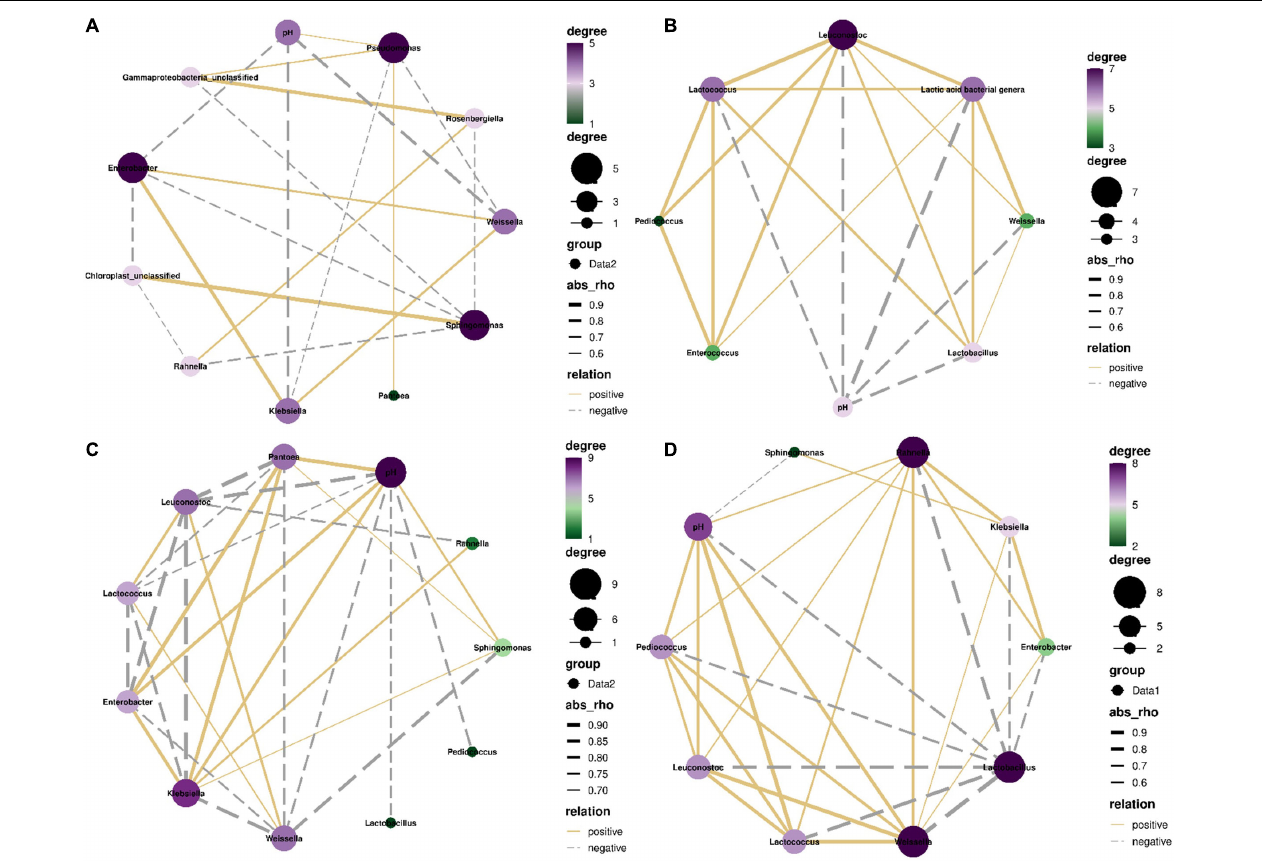
FIGURE 7 | Correlation networks among main bacterial genera (top 10) and pH in the first 5 h (A) , from 5 to 24 h (C) , and from 24 h to 60 days (D) , and among main lactic acid bacterial genera and pH in the first 5 h (B) . Absolute value of correlation coefficient > 0.5 and P value < 0.05.